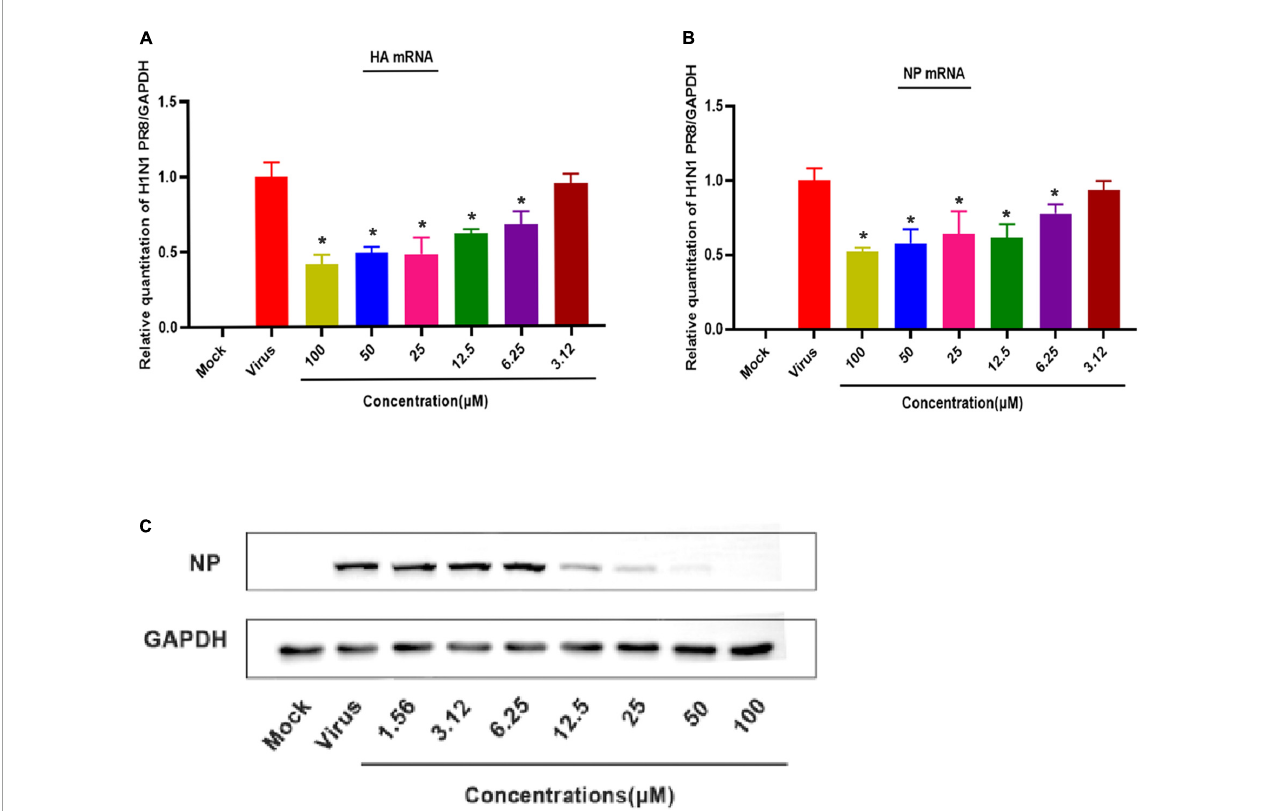
FIGURE4 Patchouli alcohol attenuates mRNA transcription and protein expression of the influenza A virus in MDCK Cells. (A) The inhibitory effect of Patchouli alcohol on the transcription of influenza A/Puerto Rico/8/34 (H1N1) strain HA mRNA was detected by qRT-PCR at 48 h post-infection. n = 3, each concentration conducted in triplicate. * P < 0.05, compared to the viral control group. (B) The inhibitory effect of Patchouli alcohol on the transcription of influenza A/Puerto Rico/8/34 (H1N1) strain NP mRNA was detected by qRT-PCR at 48 h post-infection. n = 3, each concentration conducted in triplicate. * P < 0.05, compared to the viral control group. (C) The inhibitory effect of Patchouli alcohol on the expression of influenza A/Puerto Rico/8/34 (H1N1) strain NP protein was detected by western blot at 48 h post-infection. n = 3, each concentration conducted in